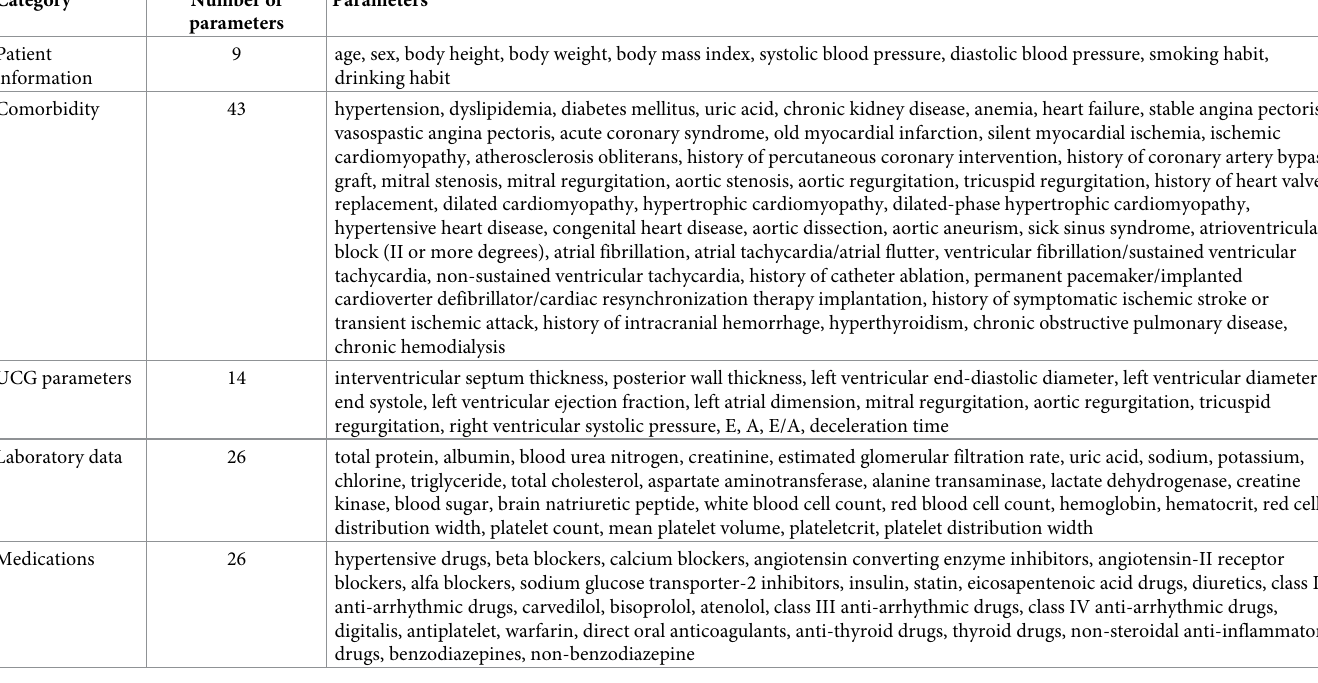
Table 1. Parameters assessed in the prediction